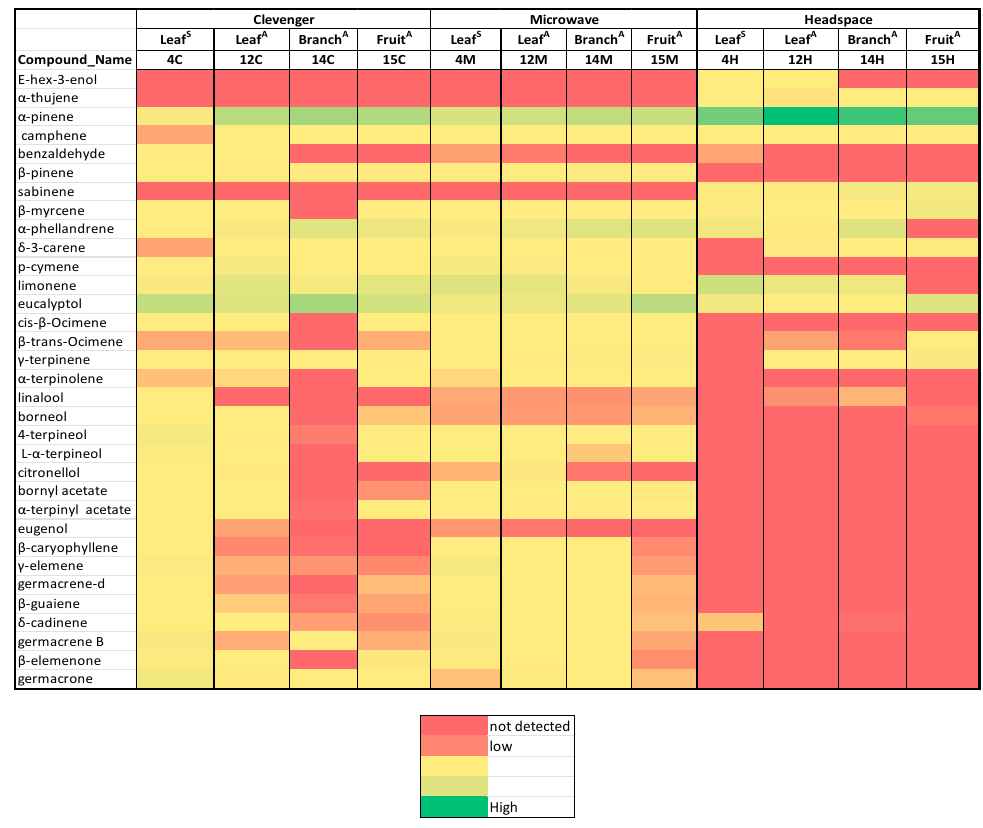
Figure 1. Heatmap showing the relative compositions of major components in extracted essential oils and volatiles from different plant parts of bog myrtle; A and S in superscript denote autumn and summer collection seasons, respectively; components with peak area percentage > 1% in at least one sample have been included.